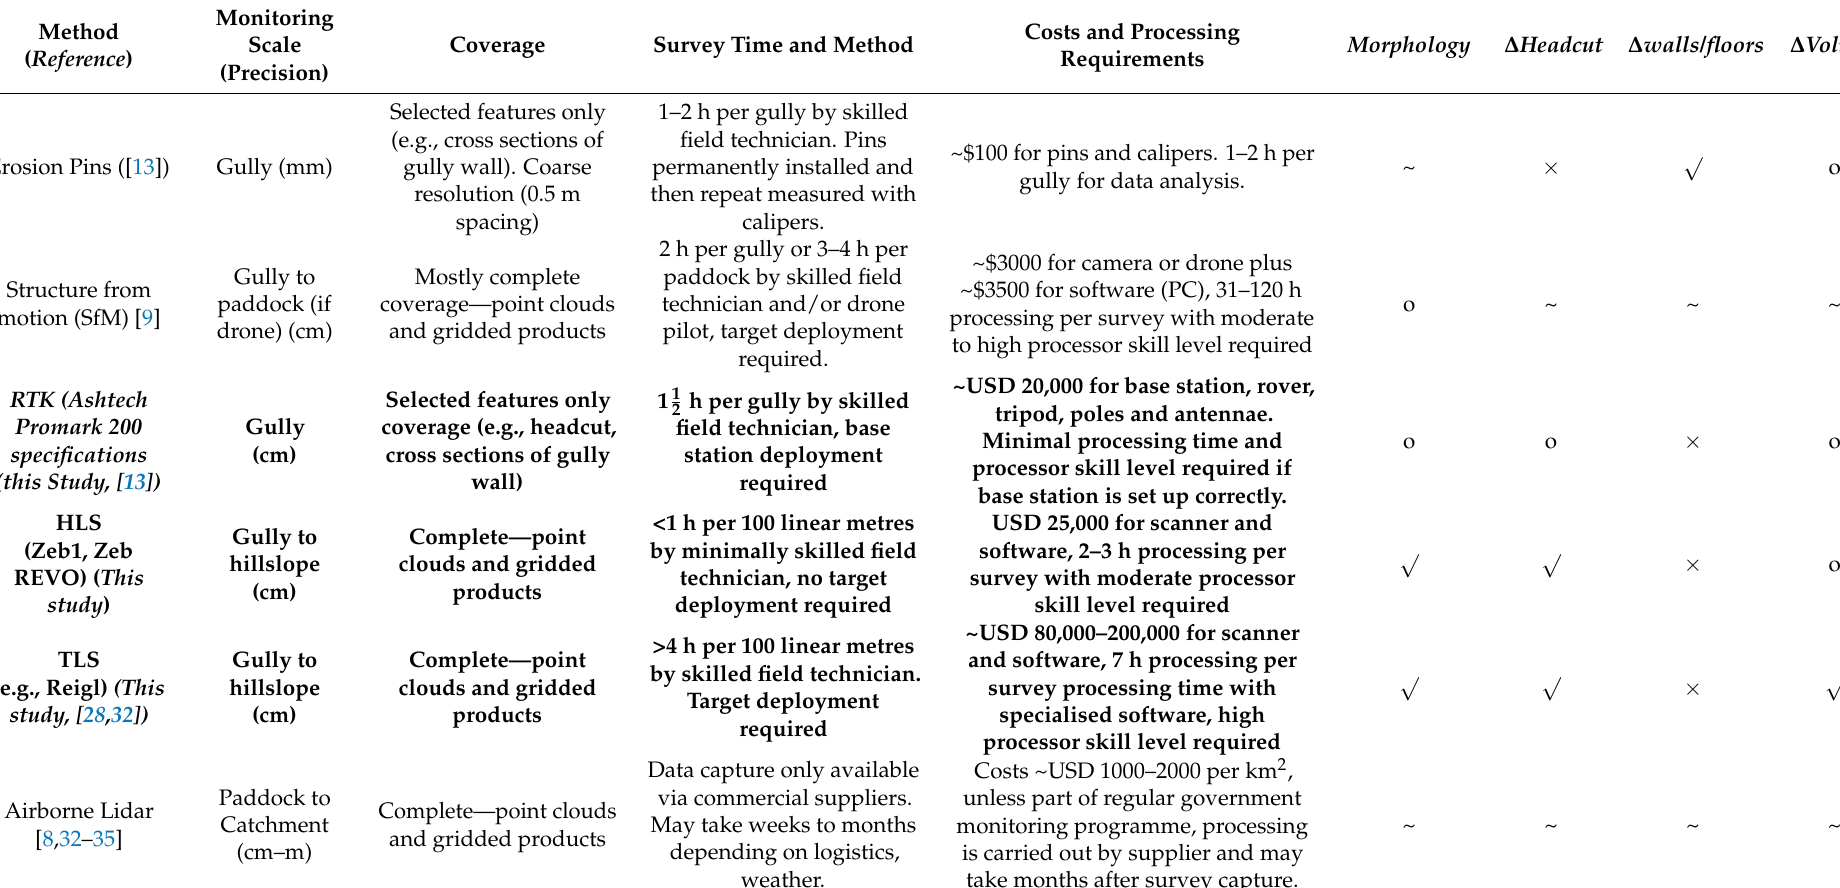
Table 6. Comparison of scale, field survey time and method, costs and processing requirements for common gully monitoring approaches, including HLS. Methods are sorted by costs and processing requirements. Four columns on the right indicate each method according to its ability to characterize gully morphology and annual changes ( ∆ ) in linear gullies such as the one in this study. SfM and erosion pins were evaluated at this study site in other studies. Airbone Lidar has not been assessed at this